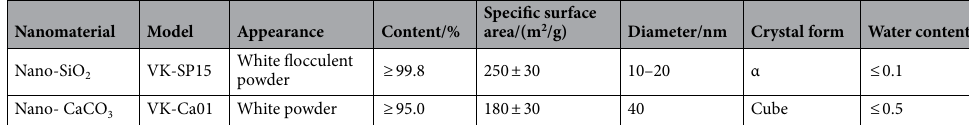
Table 4. Main performance indexes of the two kinds of nanoparticles.